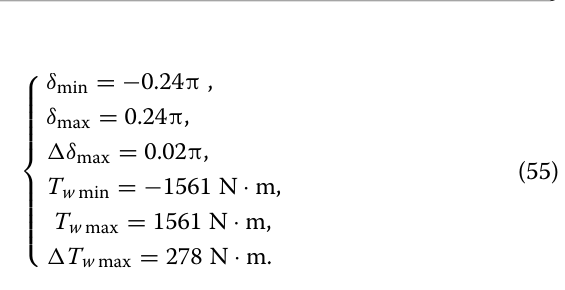
Figure 8 The planned motion and trajectory in the lateral-rear offset impact scenario